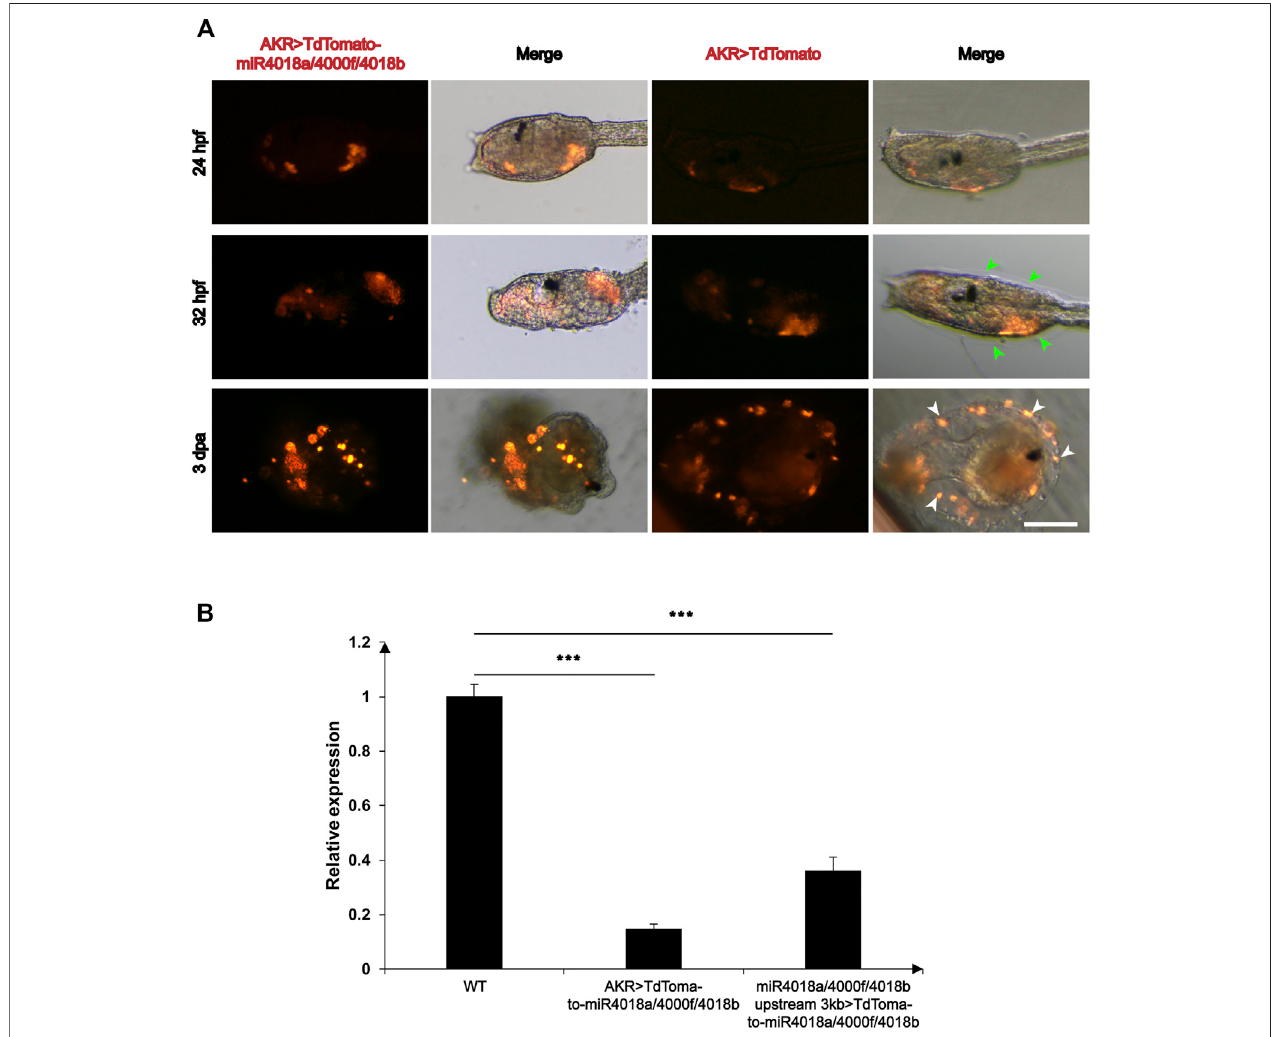
FIGURE 2 | Overexpression of miR4018a / 4000f / 4018b cluster caused failure of cellulose formation in larvae and loss of tunic cells in the metamorphic larvae. (A) AKR > miR4018a/4000f/4018b-TdTomaoto and AKR > TdTomato (control) were electroporated in the fertilized eggs, respectively. At 32 hpf, the cellulose could be observed surrounding the trunk in AKR > TdTomato -expressed larvae (green arrowheads), while in AKR > miR4018a/4000f/4018b-TdTomaoto- expressed larvae, cellulose could not be observed. In 3 dpa control larvae, the cells with TdTomato-positive signal could be observed within the tunic (white arrowheads), while in miR4018a/4000f/4018b cluster-overexpressed larvae, isolated fl uorescent-positive cells could be found surrounding the larvae. Scale bar: 50 μ m. (B) The expression levelofcellulosesynthasegene( CesA )incontrolandmiRNA-overexpressiongroups.Theresultsshowedthattheexpressionlevelof CesA wasdecreasedsigni fi cantlyat the groups of AKR promoter driven and miR4018a/4000f/4018b promoter-driven miRNA cluster overexpression compared with the control group. Asterisks (***) represent statistical signi fi cance ( p < 0.001).